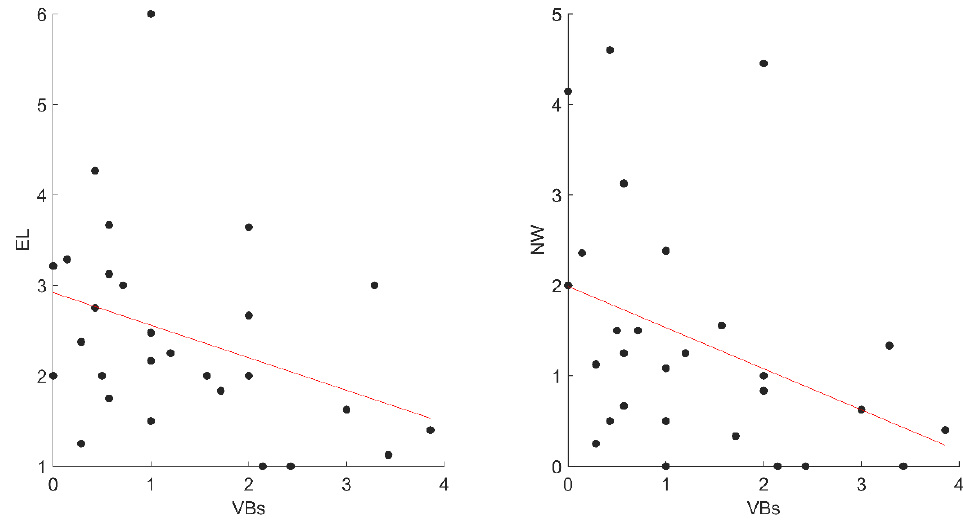
Figure 3. The significant correlations between VBs and dreams variables in STs. Abbreviations: VBs, ST Verbal; EL, Emotional Intensity; NW, negative words, STs, Sleep Talkers’ group.